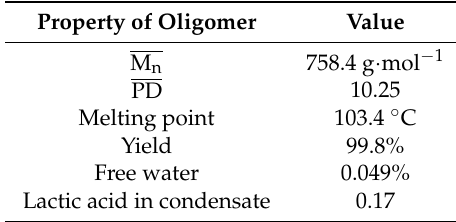
Figure 5. Free water fraction in the oligomeric lactic acid depending on the polymerization degree. Table 1. Oligomeric lactic acid properties.